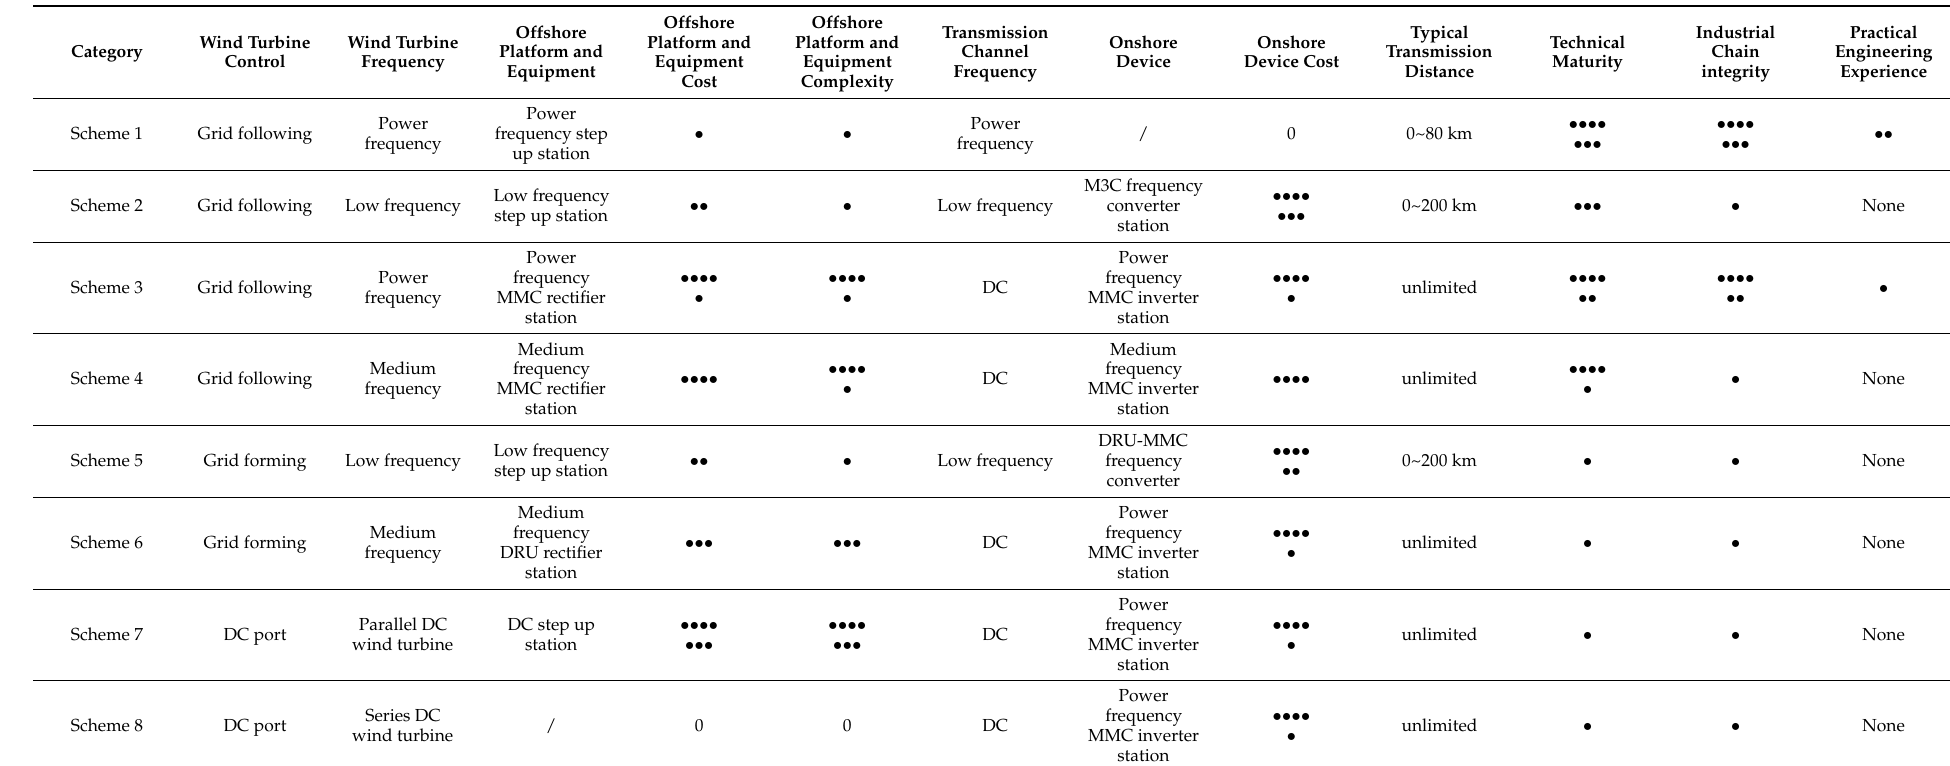
Table 2. Summary of technical characteristics of various